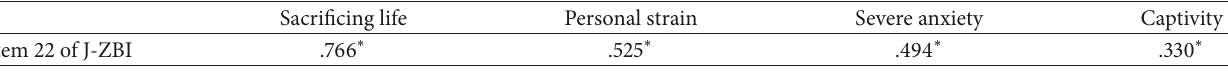
Table 4: Four-factor model (J-ZBI 15) and item 22 correlation.